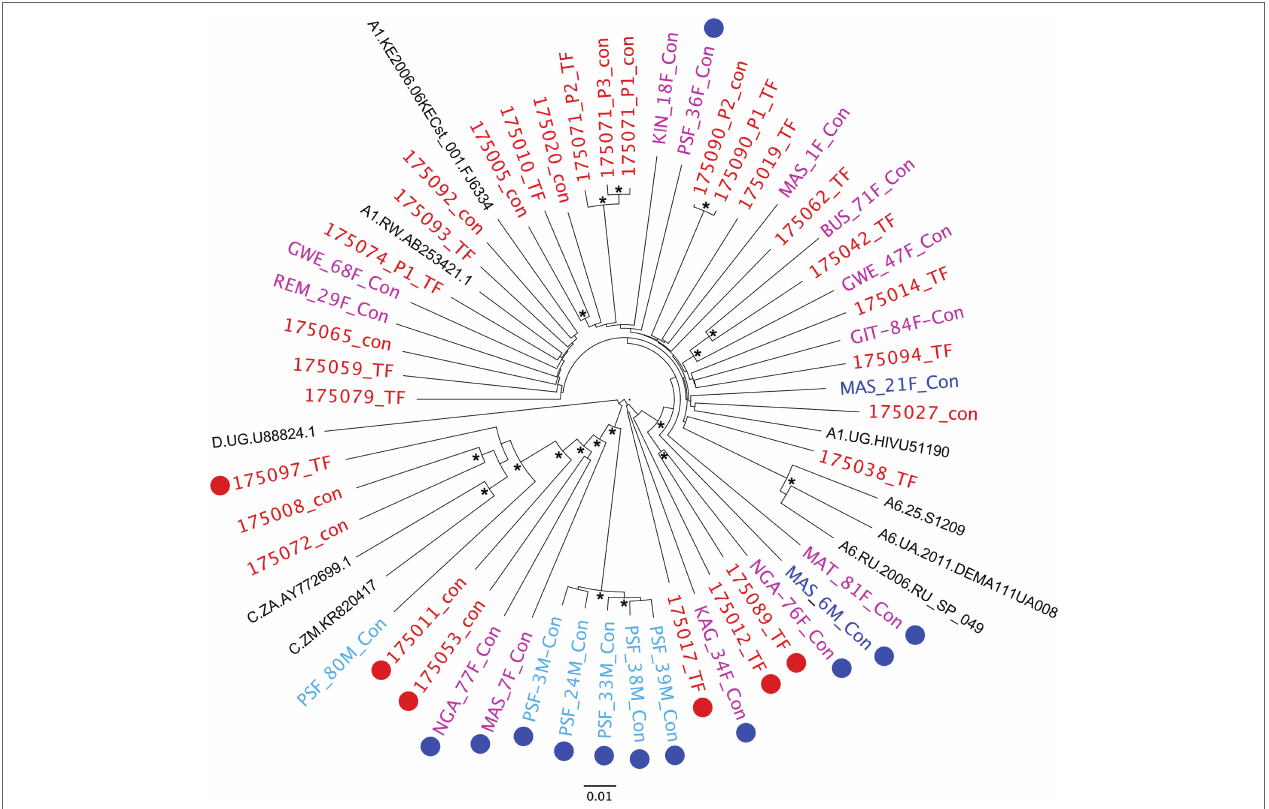
FIGURE 4 | Phylogenetic analysis of virus sequences from recent infections in the context of Protocol C acute infections. Neighbor-joining tree representing NFLG sequences of viruses from 21 recent infections and 26 acute Protocol C recipients. Origin of the viruses is denoted by color – Red, Protocol C; Blue, Discordant Couple; Magenta, FSW; Cyan, MSM. Recombinant viruses are highlighted by appended Red (Protocol C) and Blue (Recent Infection) circles. Nodes with bootstrap values > 0.9 are denoted with an